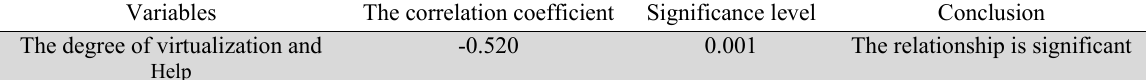
Variables The correlation coefficient Significance level The degree of virtualization and